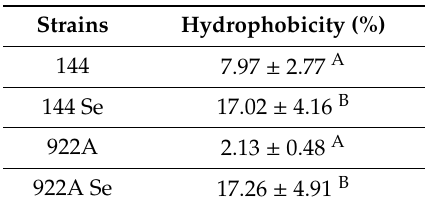
Table 3. Hydrophobicity of the cell surface of selenium-enriched and parental strains of Streptococcus thermophilus CCDM 144 and Enterococcus faecium CCDM